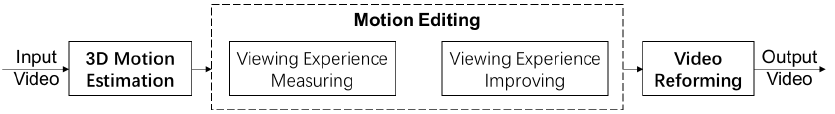
Figure 1. System